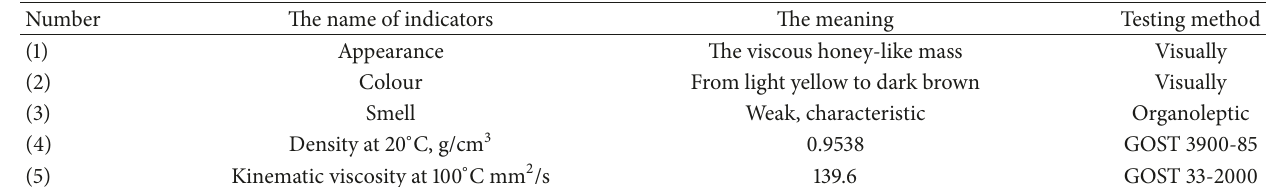
Table 5: Physical-chemical characteristics of the PFM.